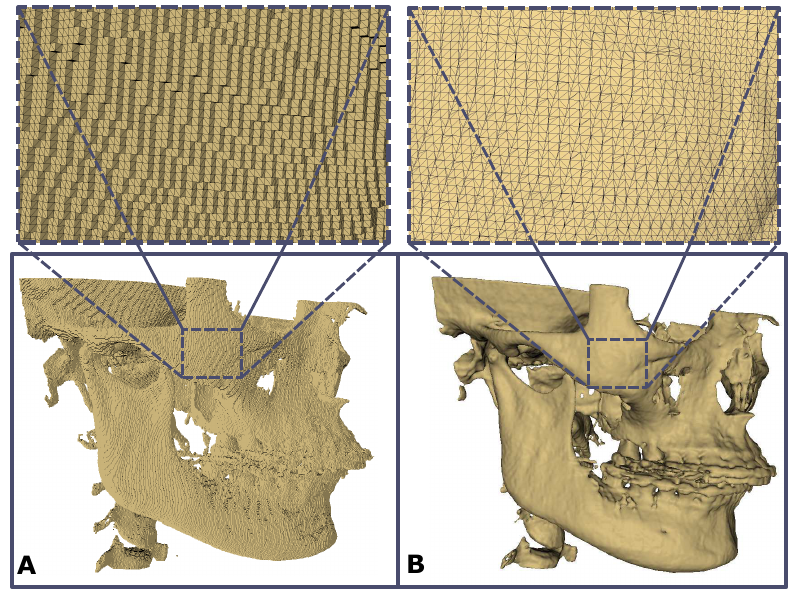
Figure 5. Reconstruction of segmented bone. ( A ) The surface of the bone after segmentation, ( B ) Reconstructed surface of the bone. At the top, are shown the small fragments of surfaces before and after